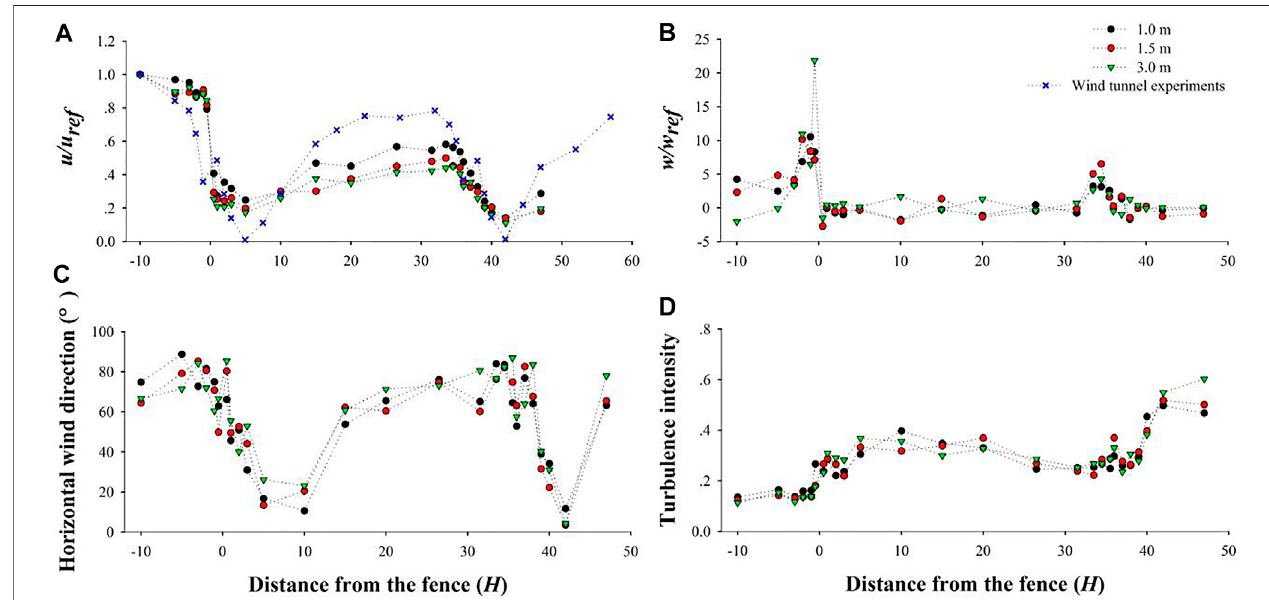
FIGURE 9 | Sand transport rate pro fi les upwind and downwind of the concrete plate-insert sand fences (CPISFs) during the observation period.